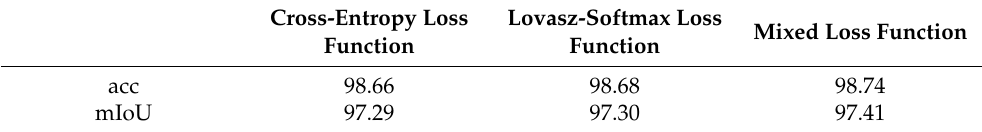
Table 3. Performance of TA-Unet when trained on different loss